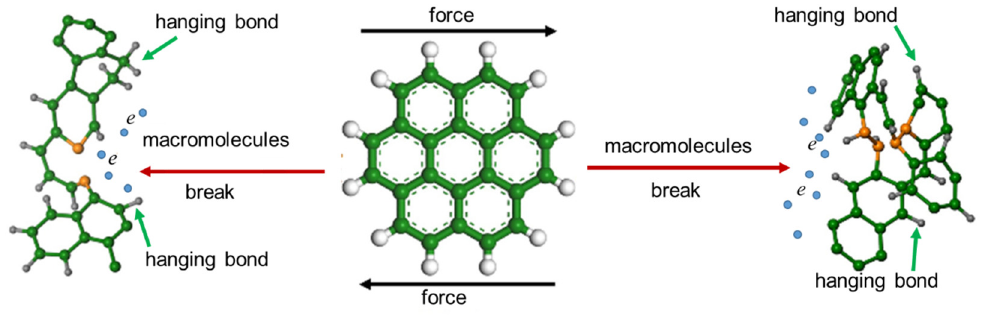
Figure 12. Schematic of fracture of coal macromolecules under external force with electron release and hanging bond formation.